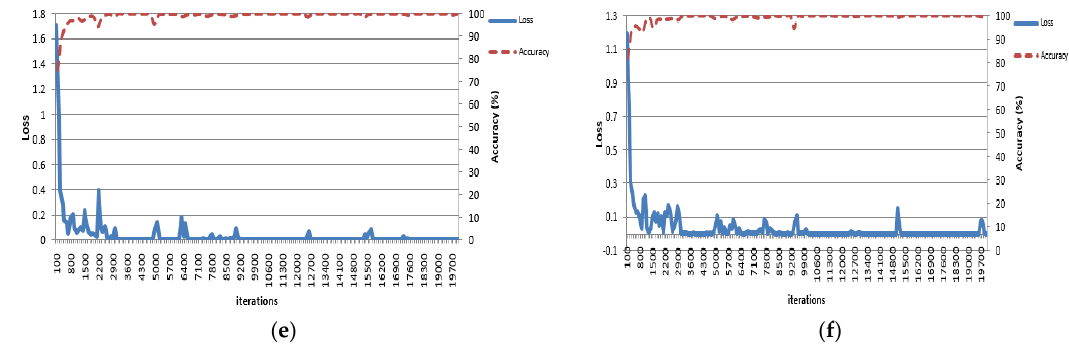
Figure 8. Loss and accuracy curves of CNN training. Using: ( a ) the augmented A sub-dataset for the training of 1st CNN of Figure 7; ( b ) the augmented B sub-dataset for the training of the first CNN of Figure 7; ( c ) the augmented A sub-dataset for the training of the second CNN of Figure 7; ( d ) the augmented B sub-dataset for the training of the second CNN of Figure 7; ( e ) the augmented A sub-dataset for the training of the third CNN of Figure 7; ( f ) the augmented B sub-dataset for the training of the third CNN of Figure 7.